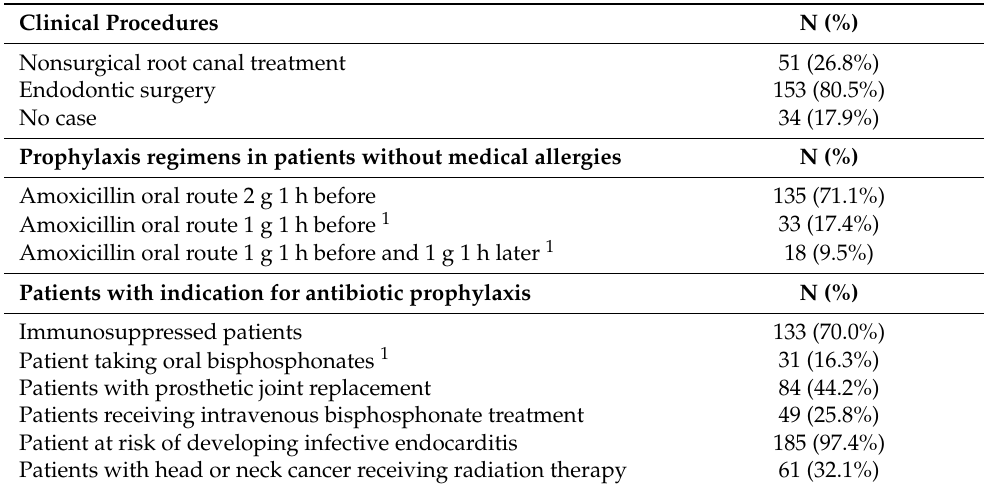
Table 4. Clinical procedures, regimens, and patients with indications for antibiotic prophylaxis in